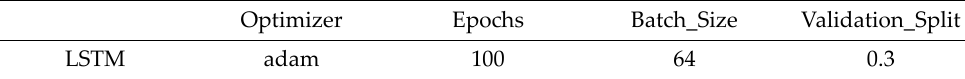
Table 4. Settings of LSTM model.